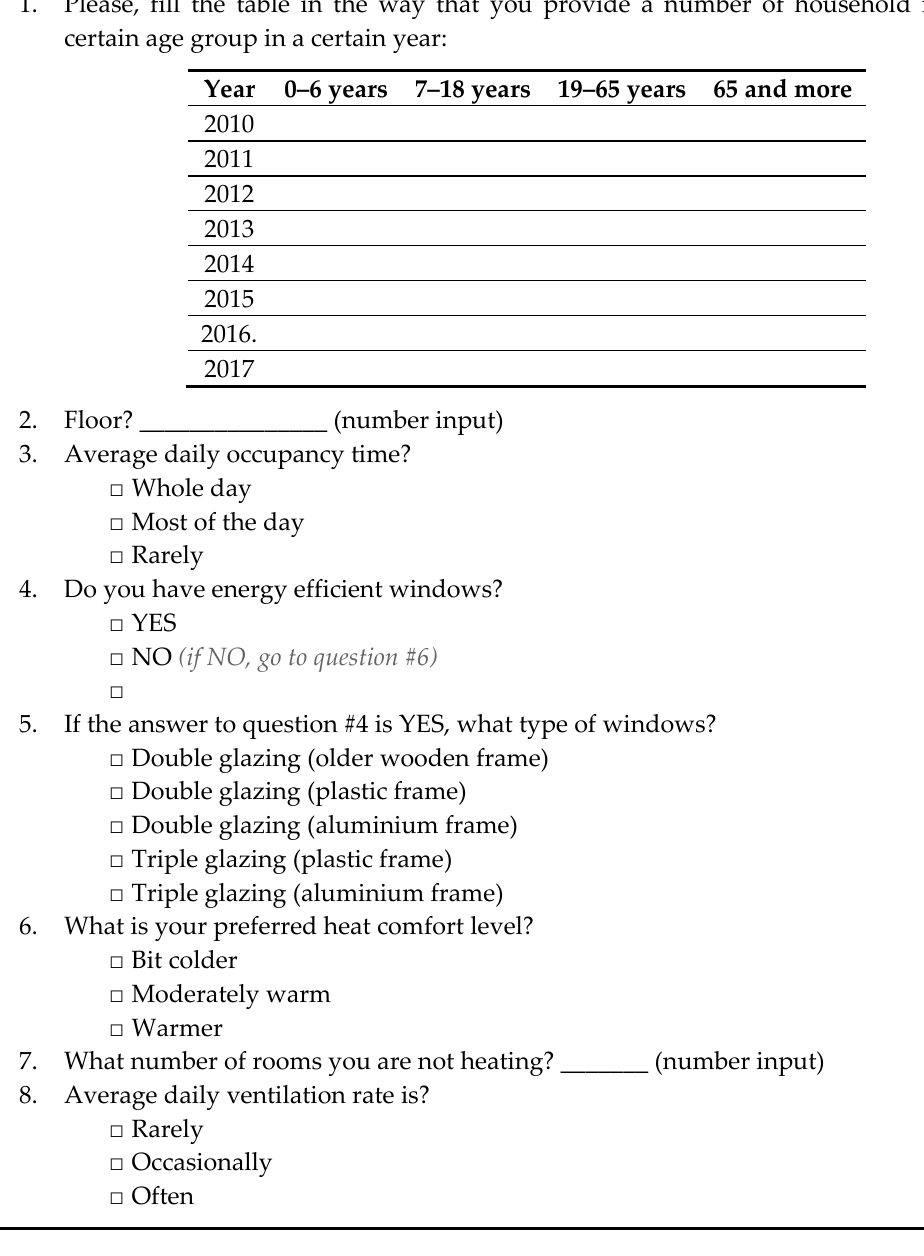
Table 2. Questionnaire structure and content.